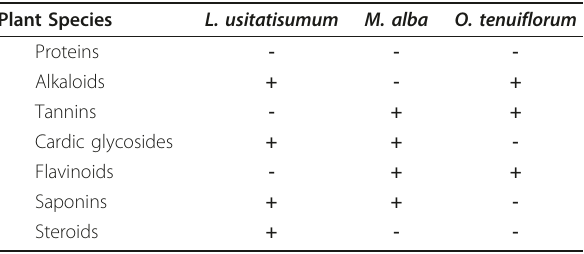
Table 3 Qualitative phytochemical analysis of isopropanol extracts exhibiting ≥ 50% inhibition on PPA activity Plant